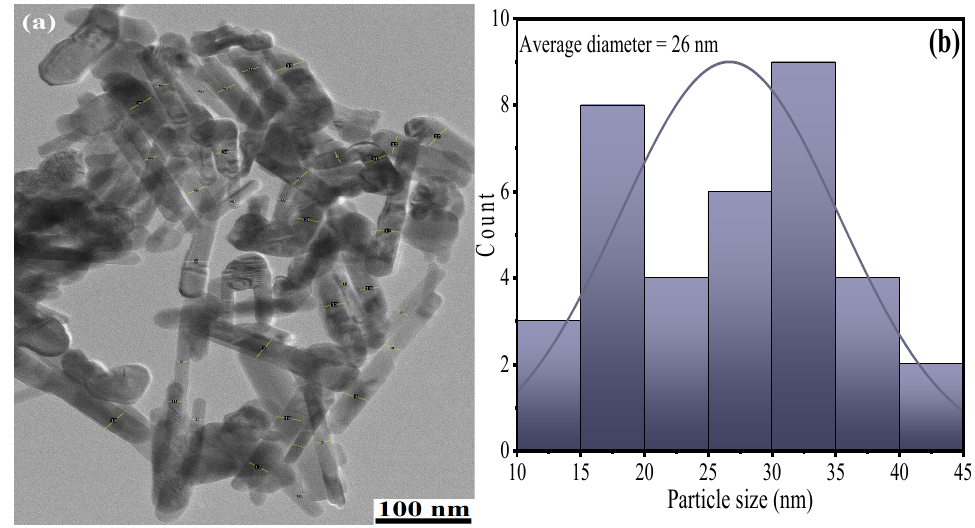
Figure 8. ( a ) Transmission electron microscopic (TEM) image of ZV@MWCNT and ( b ) gaussian distribution curve for average particle distribution.